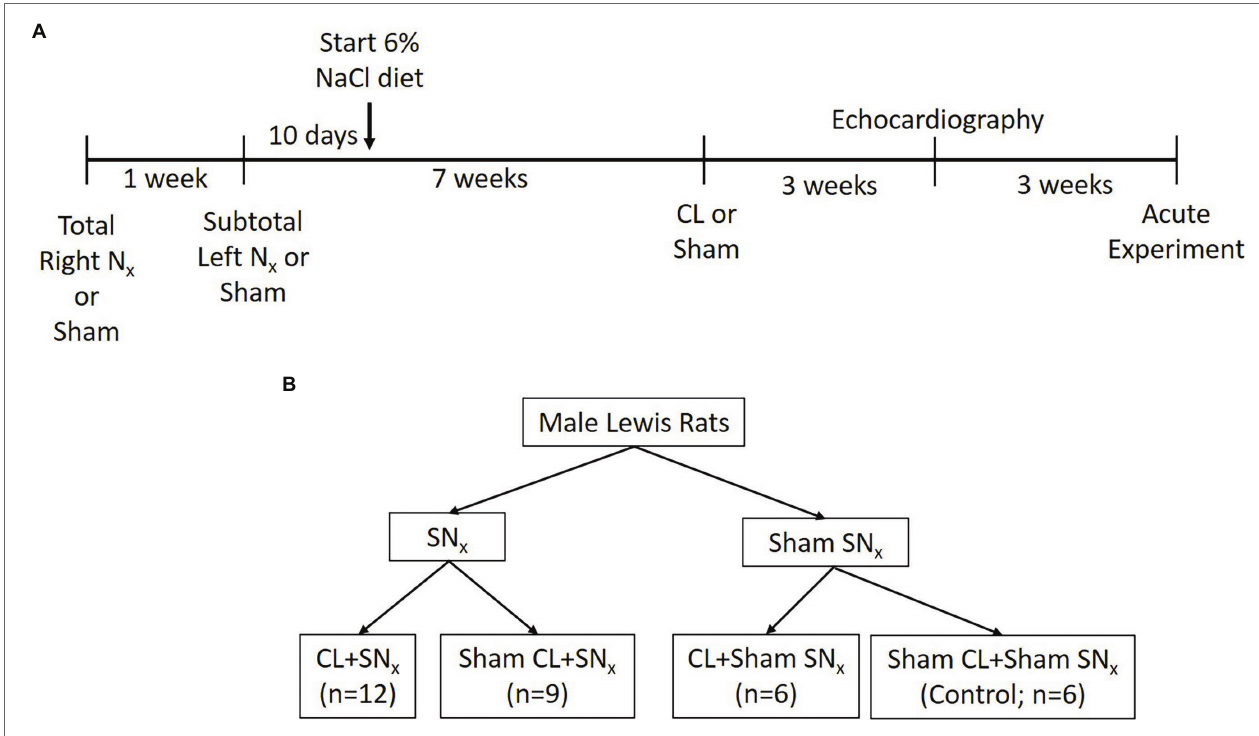
FIGURE 1 | Schematic representation of surgical timelines (A) and experimental groups (B)